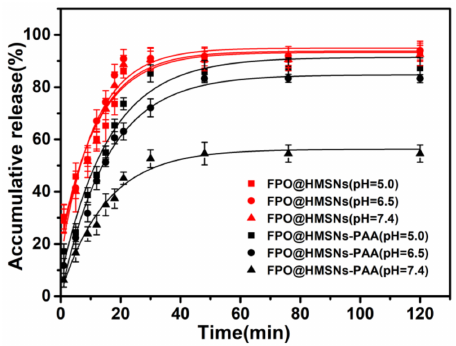
Figure 4. FPO release profiles from FPO@HMSNs and FPO@HMSNs-PAA in different PBS solution. Compared with FPO@HMSNs, FPO@HMSNs-PAA showed pH-responsive release